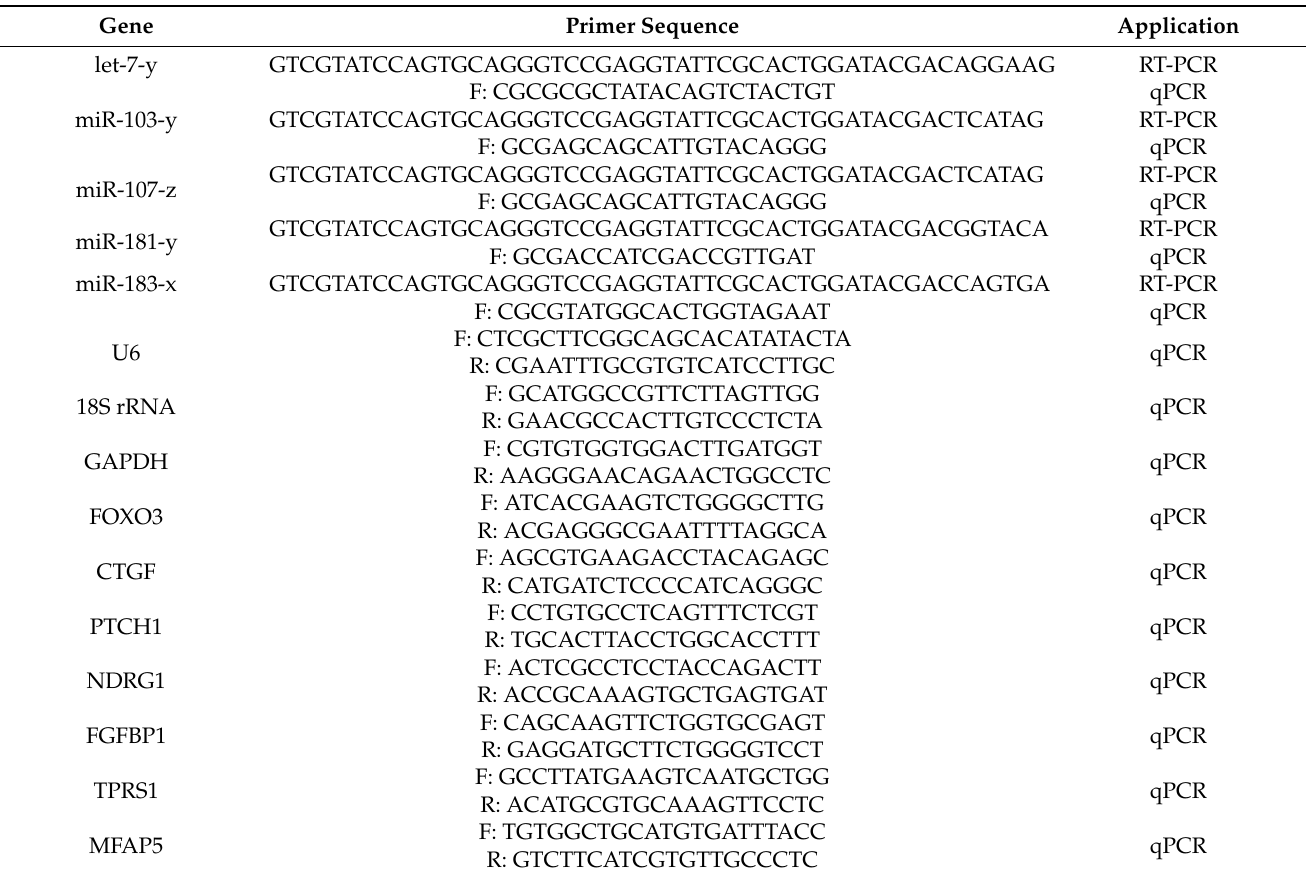
Table 1. Primer list for qRT-PCR